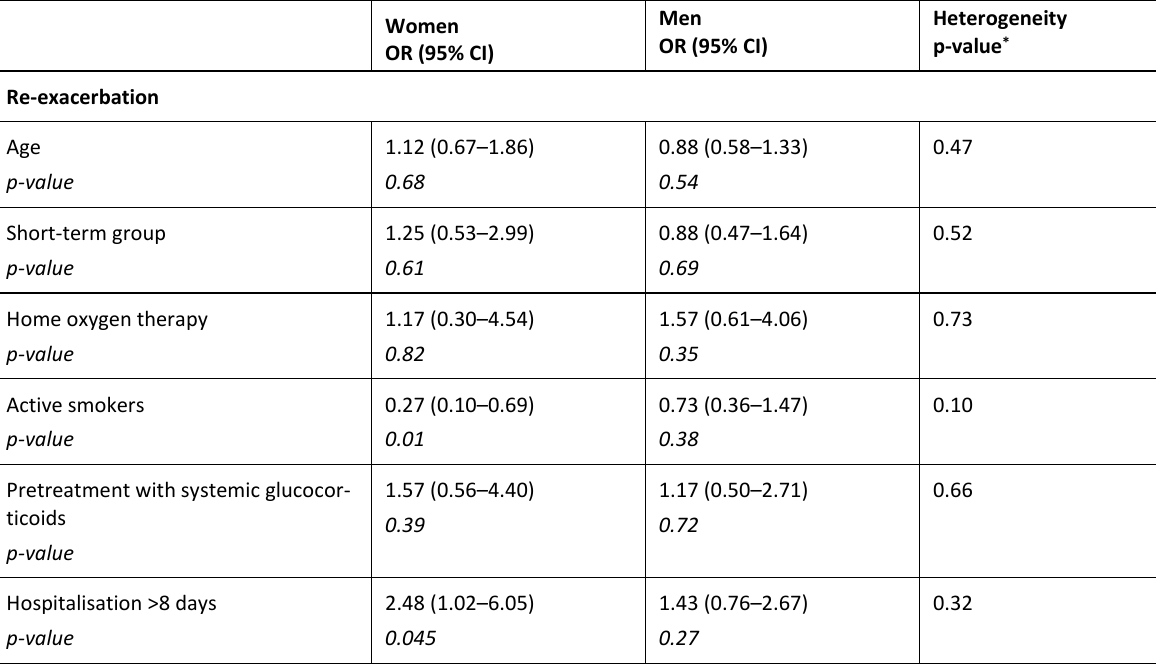
Table S4B: Multivariate analysis of re-exacerbation or re-exacerbation and/or death stratified by